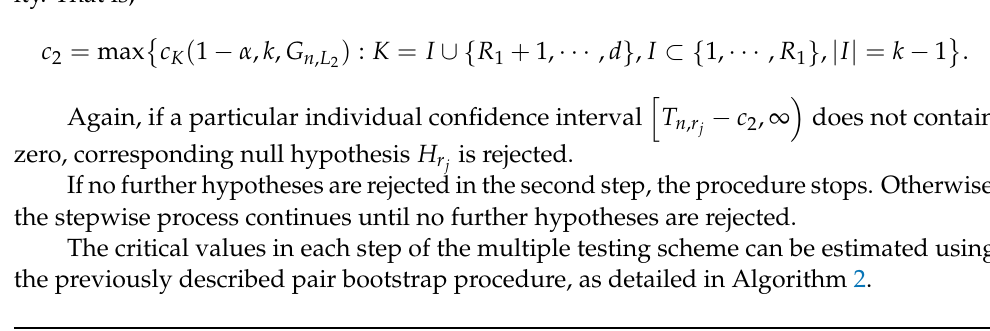
Algorithm 2 Calculate ˆ c j , j = 1, 2, . . . with pair